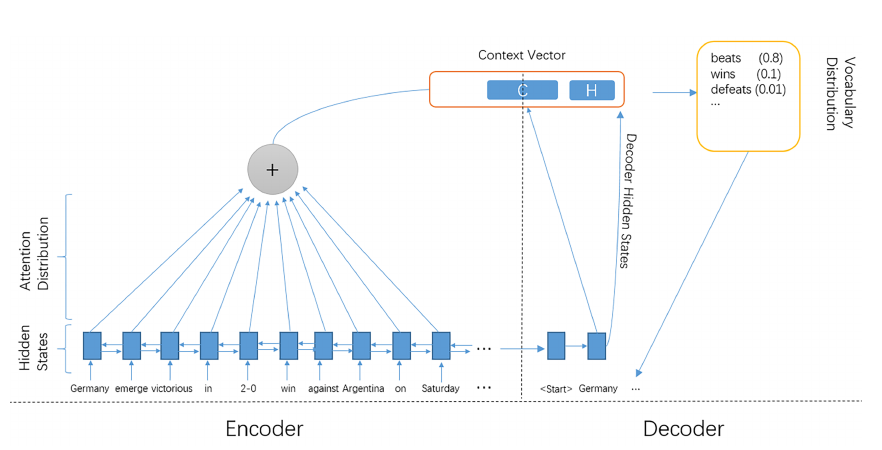
Figure 2. Illustration of the attentional sequence-to-sequence model. The model attends to relevant words in the source text to generate words of the output